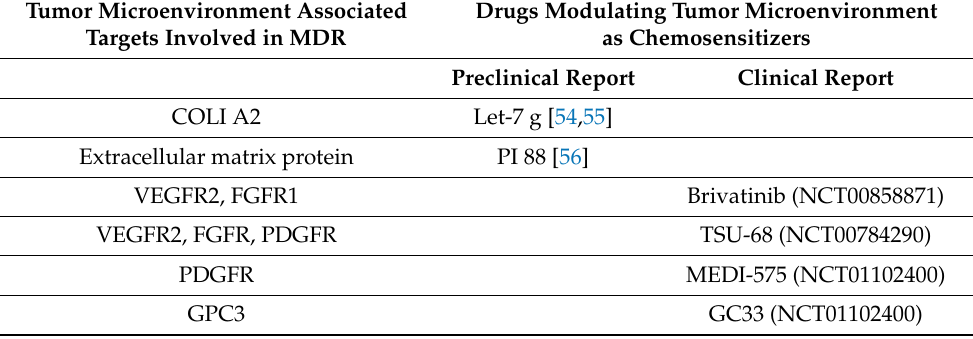
Table 3. Altered tumor microenvironment and its modulation to combat drug resistance.